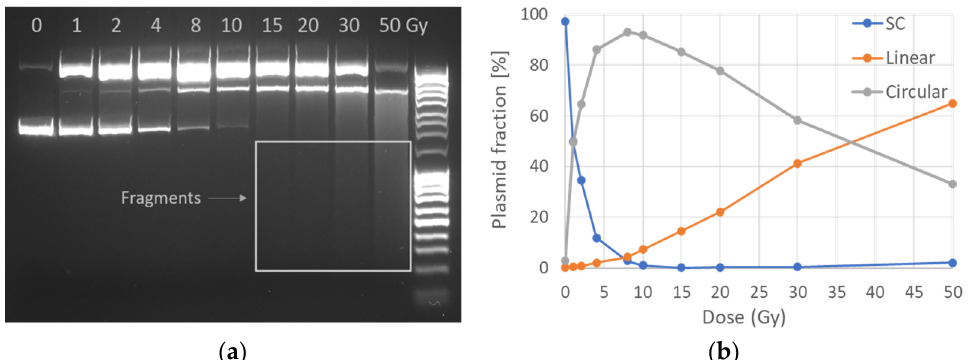
Figure 1. Electrophoretic plasmid analysis: ( a ) gel image of plasmid form transition for 10 different doses from 0 to 50 Gy with DNA ladder also included (right column). The original image has been slightly enhanced by increasing intensity in order to reveal low-intensity bands (small fragments) but not altered in other editing ways; SC, C and L are separated as expected due to their different DNA molecule mobility in the field. The image presented was oversaturated in order to visualize the fragments (smear in the last lanes). ( b ) Three plasmid forms transition with increasing dose as quantified according to gel band intensity.